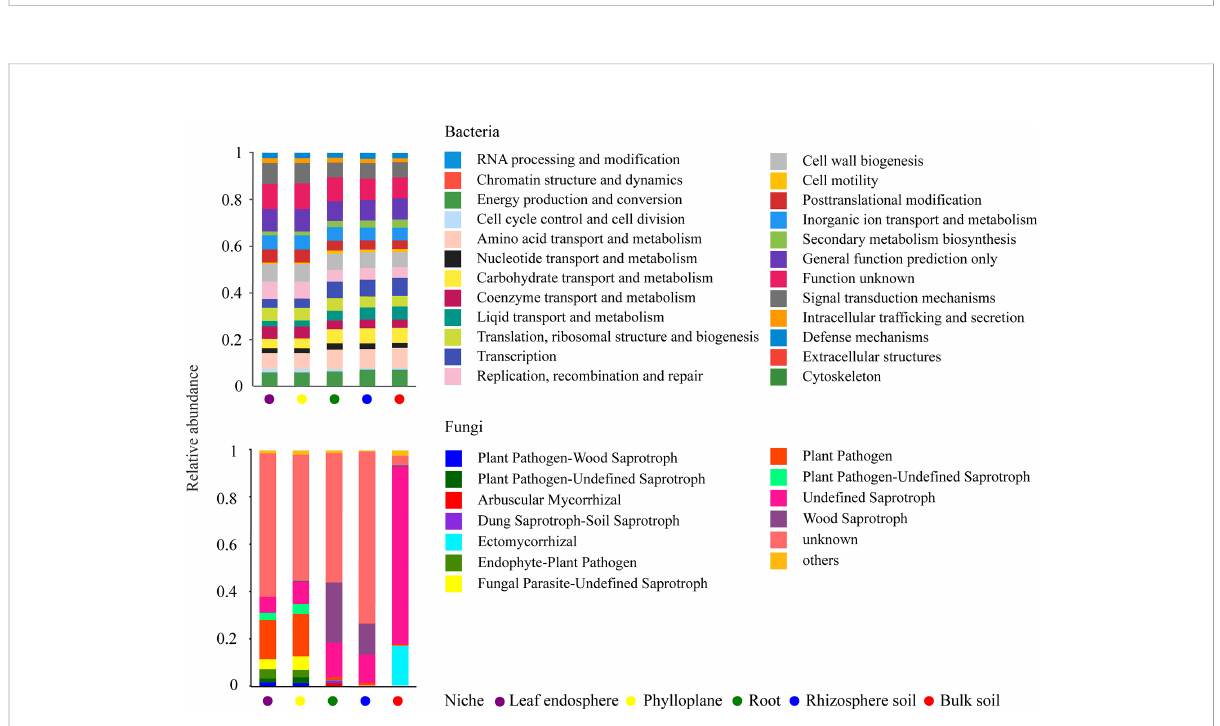
FIGURE 6 Potential functional groups of bacterial (top) and fungal (bottom) communities among different ecological